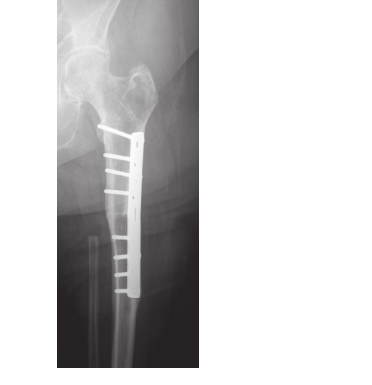
Figure 1: An anterior-posterior radiograph showing an A1- rotationplasty 12 years postoperatively without signs of pseu- darthrosis.